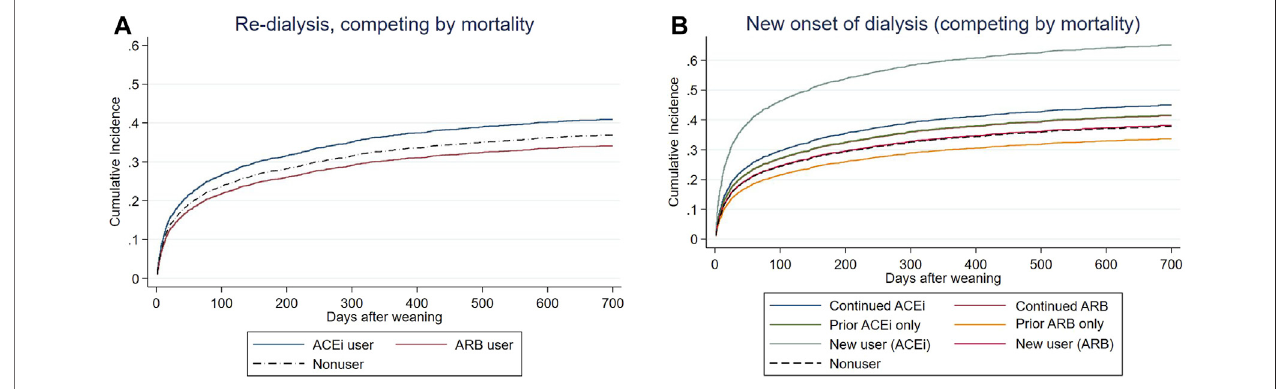
FIGURE 3 | Cox proportional plots depicting (A) end-stage kidney disease (ESKD) risk levels of before-dialysis ARB and ACEi users, as well as nonusers, and (B) ESKD risk levels of prior ARB, prior ACEi, continuing ARB, continuing ACEi, and new users, as well as nonusers, taking mortality as a competing risk after